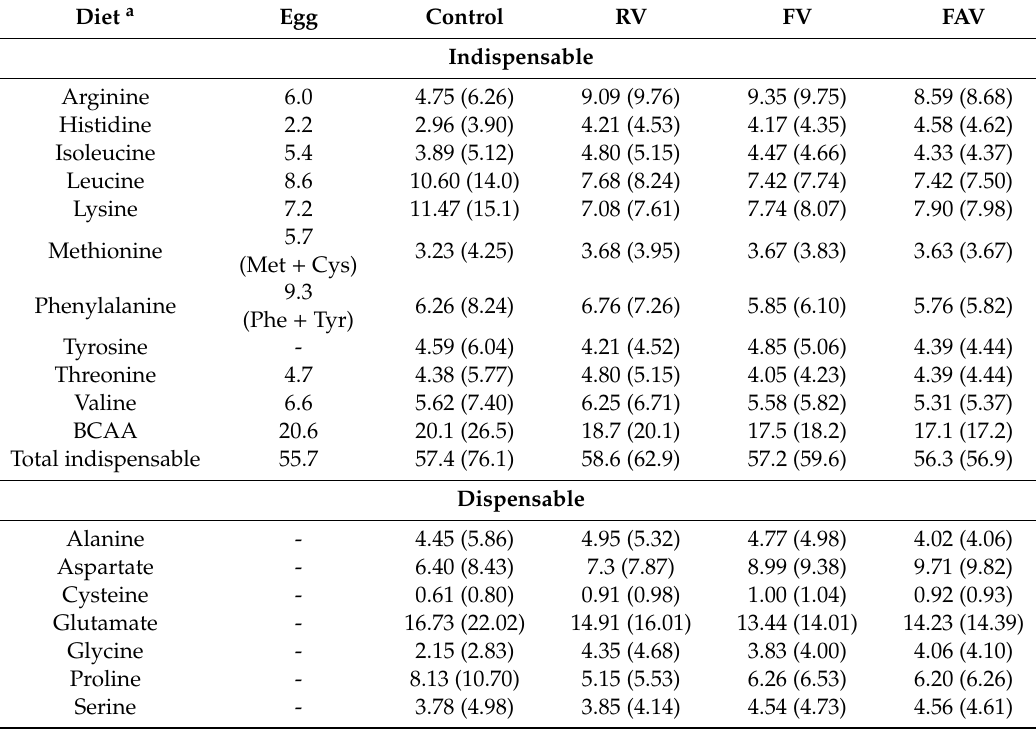
Table 2. Amino acid profile of egg protein and experimental diets expressed in g / 16 g N and amino acid content (g · kg − 1 ) of the experimental diets.